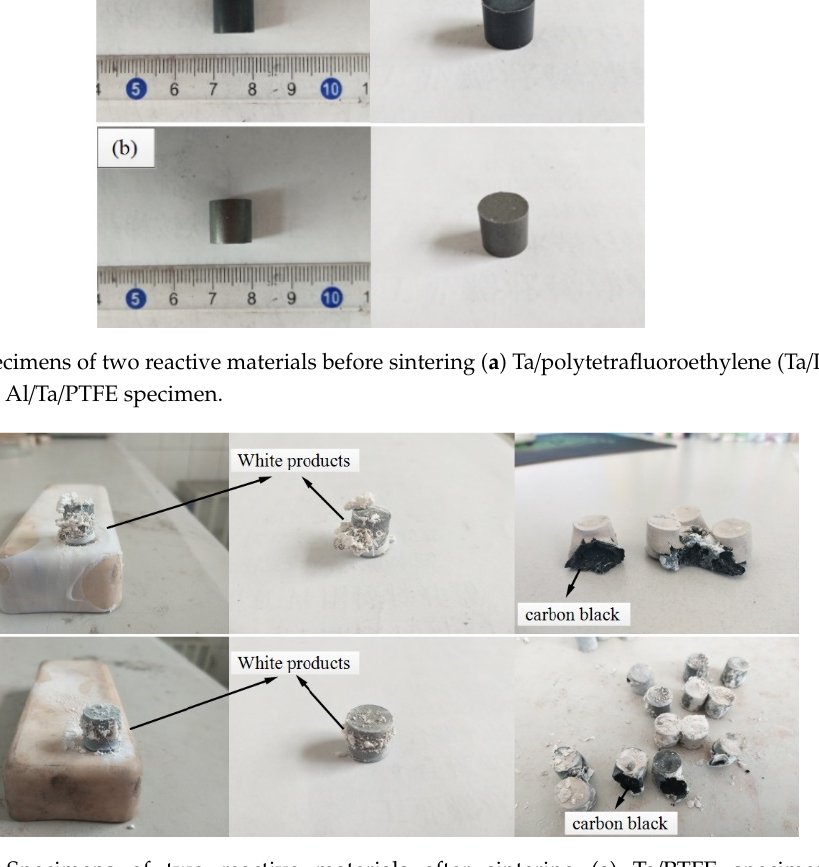
Figure 4. Specimens of two reactive materials after sintering ( a ) Ta/PTFE specimen ( b ) Al/Ta/PTFE specimen.